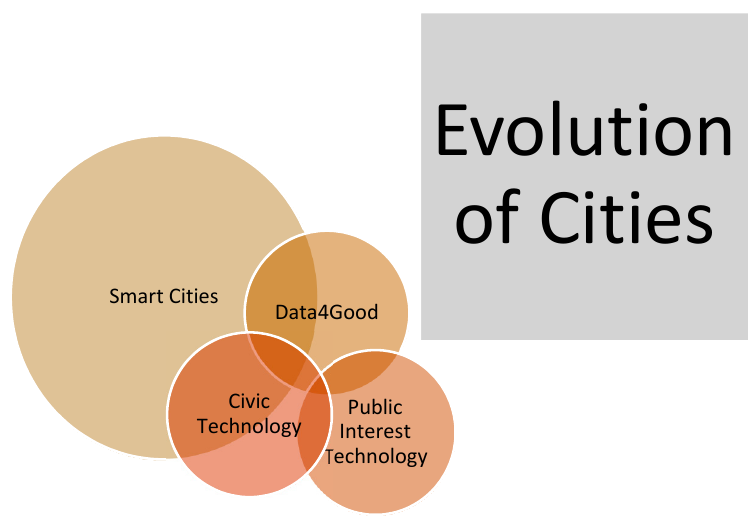
Figure 1. Relationship between the smart cities movement and related colleterial movements.